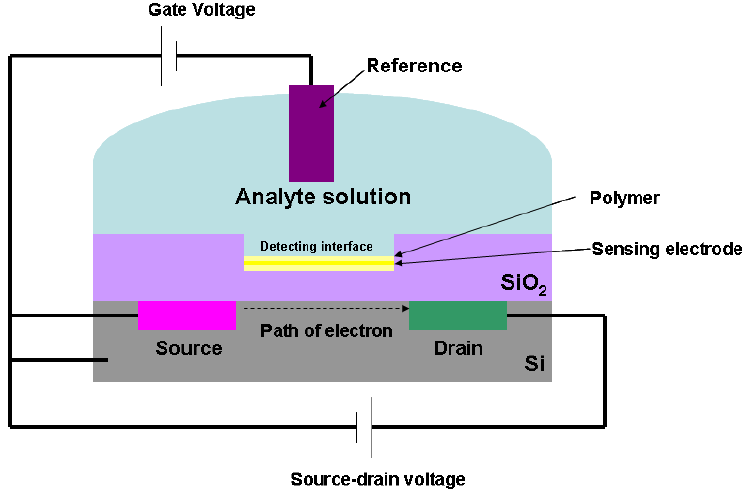
Figure 5. Schematic configuration of an ISFETs biosensor (adapted from